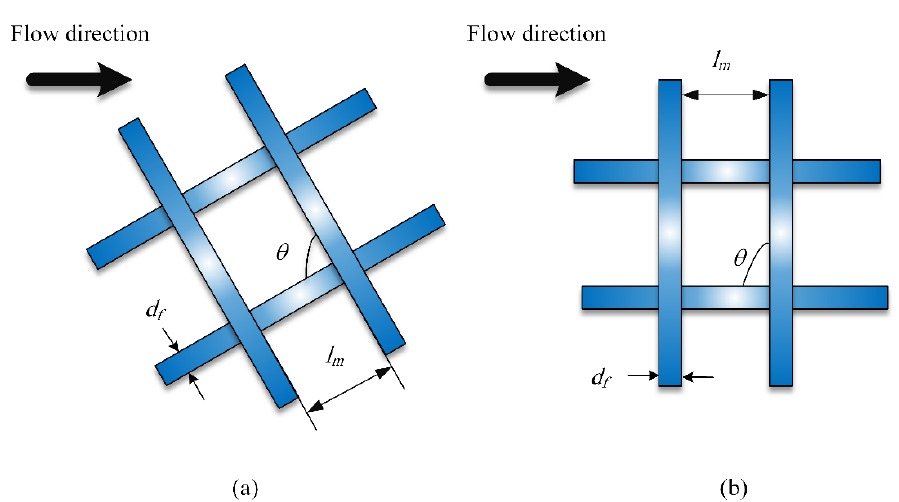
Figure A1. Spacer’s structure; ( a ) Spacer changes flow direction, ( b ) Spacers do not change flow direction [14]